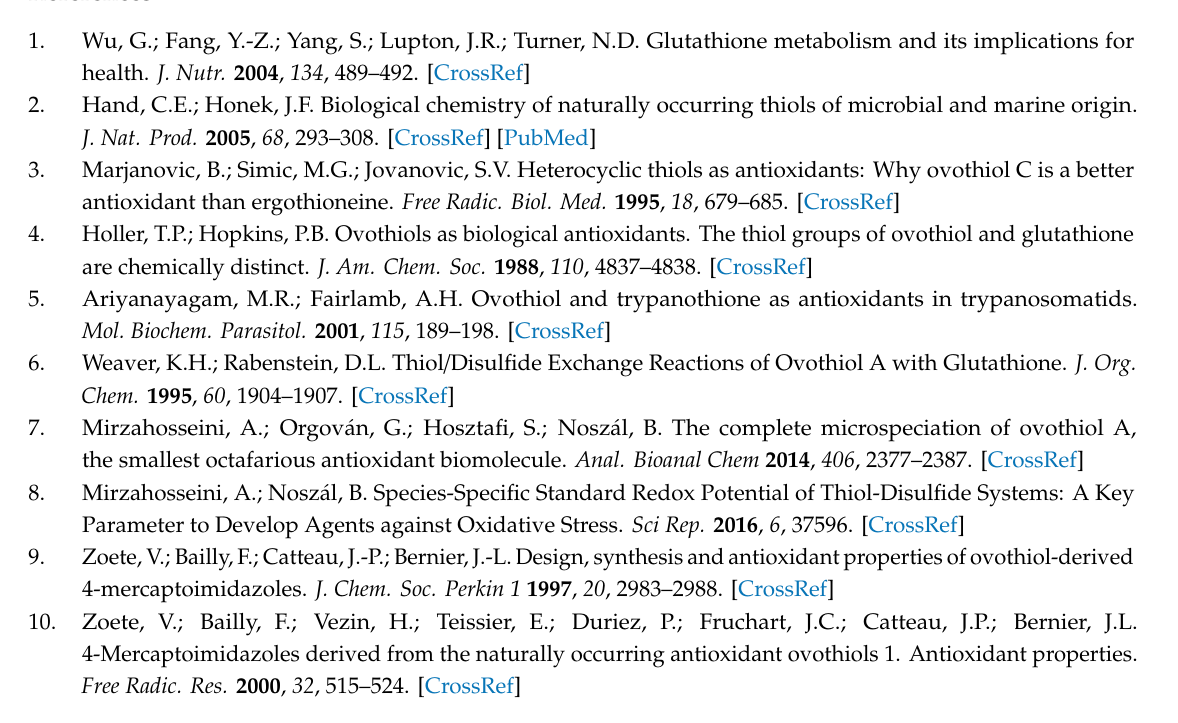
Table S1: Characterization of fish lenses used in this study. Table S2. Concentrations of histidine, ovothiol and glutathione in individual lenses of S. lucioperca and R. rutilus lacustris . Figure S1. NMR spectrum of ovothiol A (OSH). Figure S2. NMR spectrum of oxidized ovothiol A (OSSO). Figure S3. ESI-Q-TOF mass-spectrum of CID fragments (MS / MS) of isolated parent ion with m / z 202.0643 (OSH). Figure S4. ESI-Q-TOF mass-spectrum of CID fragments (MS / MS) of isolated parent ion with m / z 401.1061